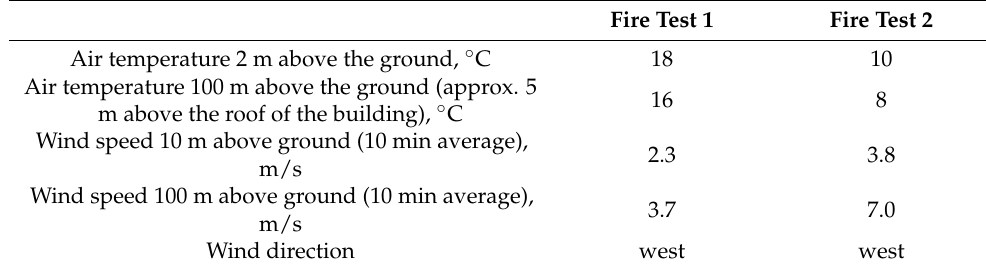
Table 2. The meteorological conditions during both fire tests.